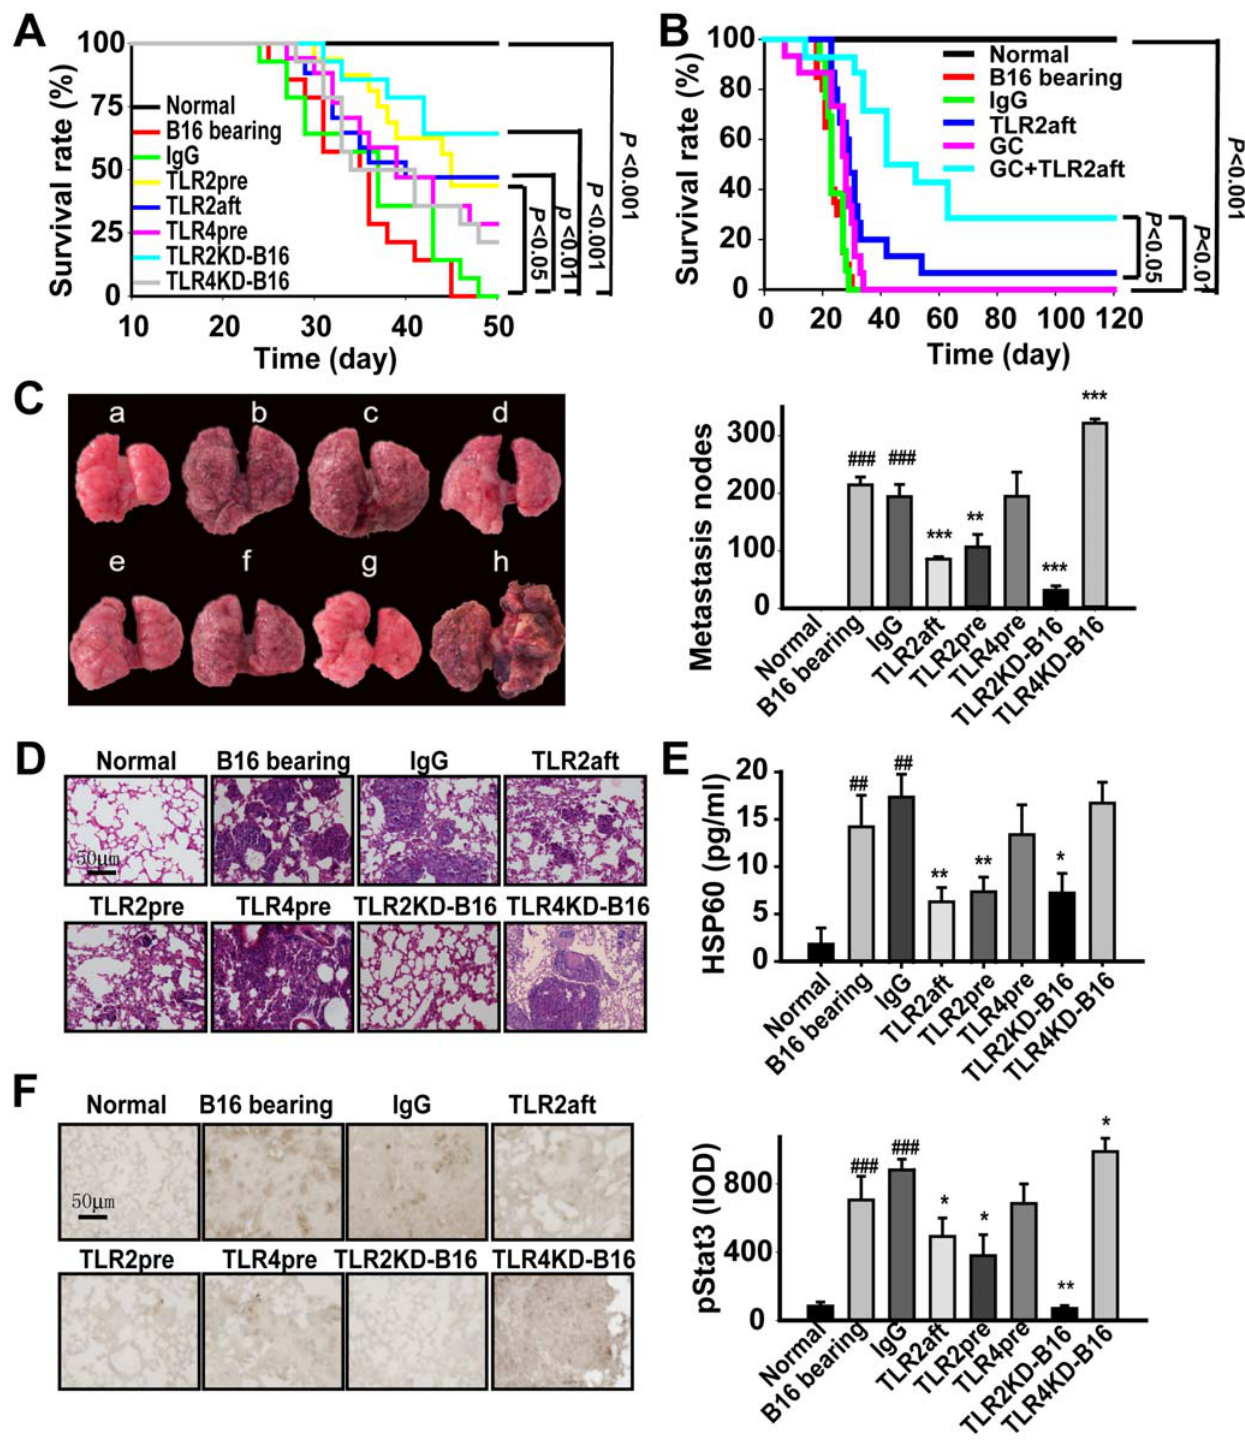
Figure 3. Targeting TLR2 attenuated pulmonary metastases of B16 cells. The mice were treated as described in the methods. (A, B) The survival rate of mice injected with B16 cells. The animal survival rate was analyzed by the Kaplan-Meier method (n § 30). (C) Targeting TLR2, but not TLR4, reduced the pulmonary metastasis nodes. Left, representative lung photographs. The animals were treated as a) sham; b) B16 cells; c) IgG; d) TLR2aft; e) TLR2pre; f) TLR4pre; g) TLR2KD-B16; and h) TLR4KD-B16. Right, summary of the pulmonary metastasis nodes. (D) The representative H&E staining image of the lungs. The nuclear division stage was assessed by H&E staining that represented a nuclear division scale. (E) The level of HSP60 in BALF detected with ELISA. (F) The phosphorylation of Stat3 in the lung of B16 melanoma-bearing mice. Data are represented as mean 6 SE of three independent experiments (n=15/group/experiment). * P , 0.05, ** P , 0.01, *** P , 0.001 versus B16 cell bearing mice; # P , 0.05, ## P , 0.01, ### P , 0.001 versus normal mice.